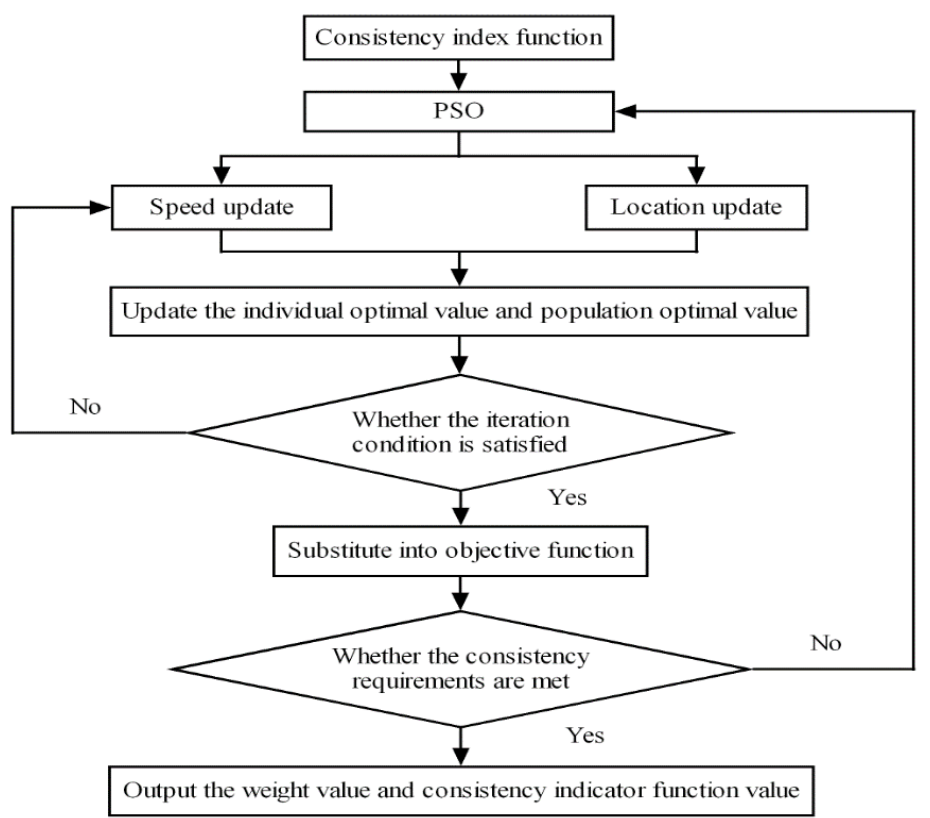
Figure 3. Flow chart of PSO-AHP algorithm.